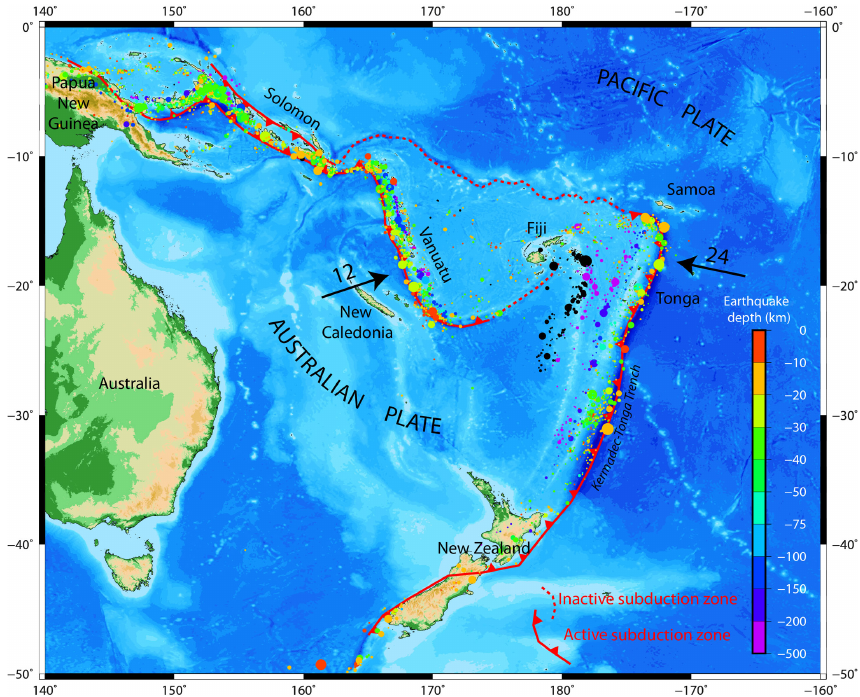
Figure 1. Regional tectonic settings around New Caledonia. The colored dots represent M w ≥ 6 . 3 earthquakes recorded since 1 January 1900, and their sizes are a function of magnitude. The black arrows symbolize the relative motion of the Australian and Pacific plates (cmyr − 1